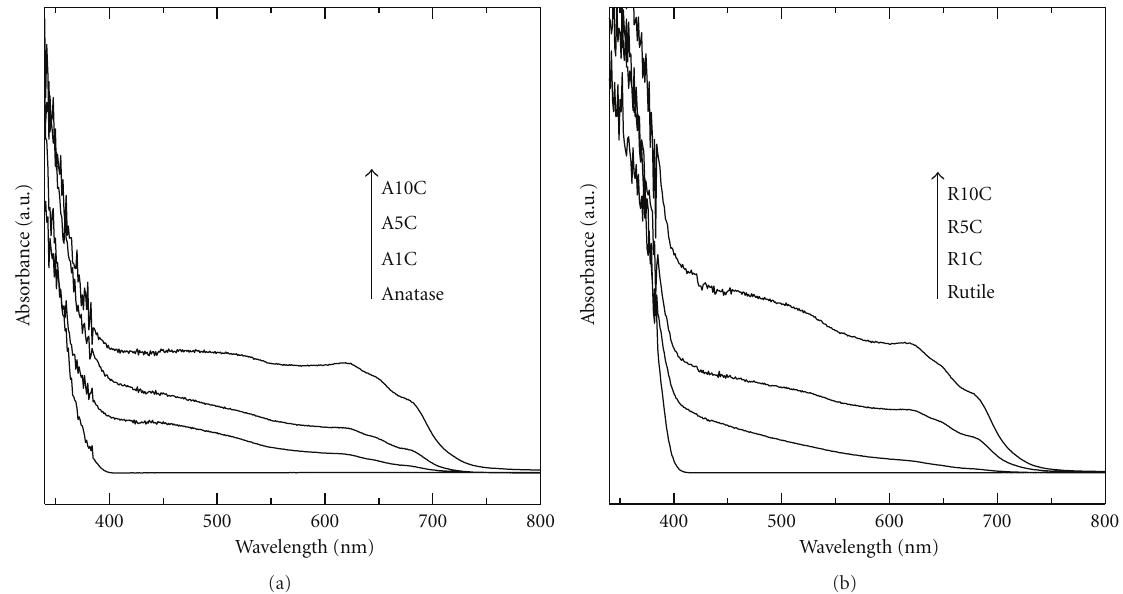
Figure 1: UV-vis spectra of the samples. (a) The anatase, A1C, A5C, and A10C samples, (b) the rutile, R1C, R5C, and R10C